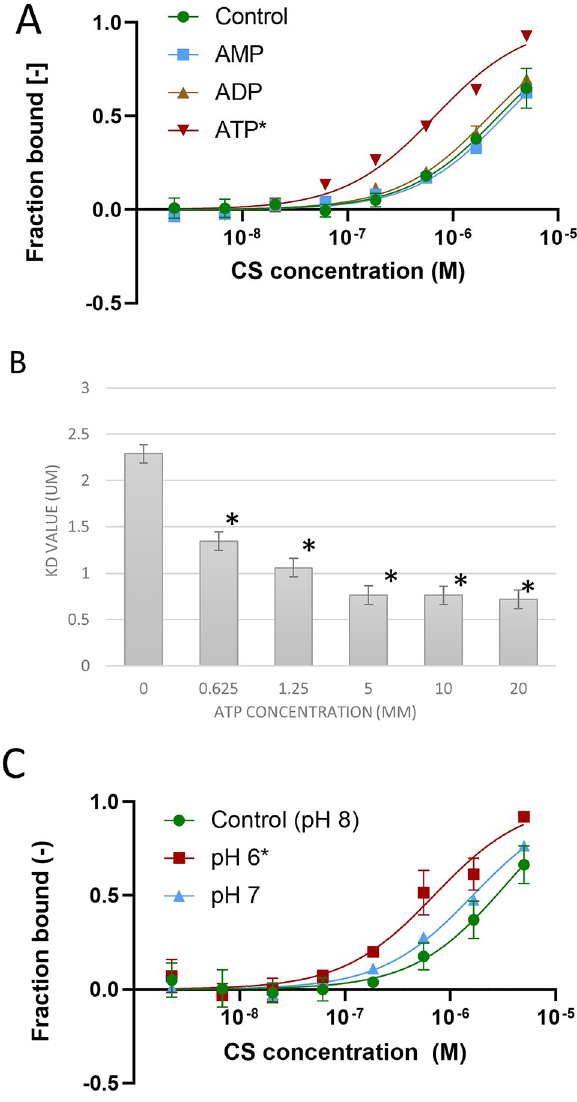
Figure 3. Effects of mitochondrial energy status on the affinity of the MDH-CS multi-enzyme complex. The affinity of the MDH-CS multi-enzyme complex was analyzed by microscale thermophoresis (MST) using fluorescently labeled MDH and CS as the ligands. Points and bars represent the means, and the error bars represent the standard deviations of three measurements. Asterisks indicate the conditions that showed significant K d differences with no K d confidence overlap with the control. ( A ) Effects of 10 mM ATP (red), ADP (brown), and AMP (blue) on the interaction between CS and MDH. Curves represent the response (fraction bound) against CS concentration (M). The interaction was assessed in the MST buffer (control, green circle) or those with 10 mM of metabolites. ( B ) Dose-dependent effect of ATP on the dissociation constant ( K d ) of the MDH-CS interaction. K d was calculated from the response curve against CS concentration. ( C ) Effects of pH. Curves represent the response (fraction bound) against CS concentration. The interaction was assessed in the MST buffer with pH 8.0 (control, green) or that with pH 6.0 (red) and 7.0